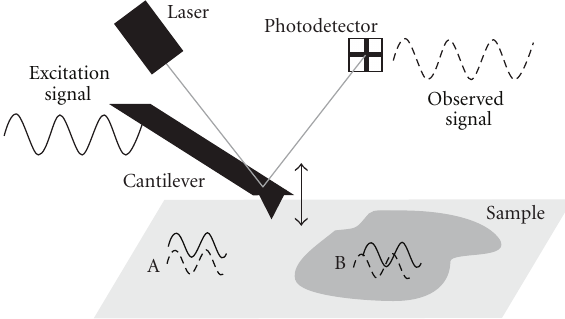
F 6: Idea of construction “material contrast” image using IC- AFM (places A and B have highly different mechanical